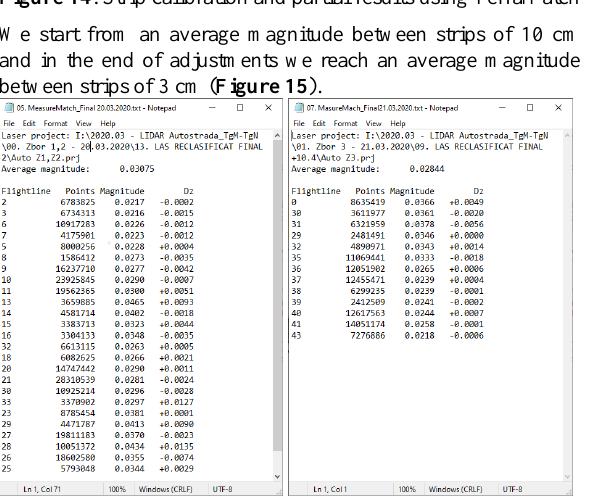
Figure 15 . Final results regarding the calibration accuracy of the LIDAR strips (left - flight from 20.03.2020, right - flight from 21.03.2020)